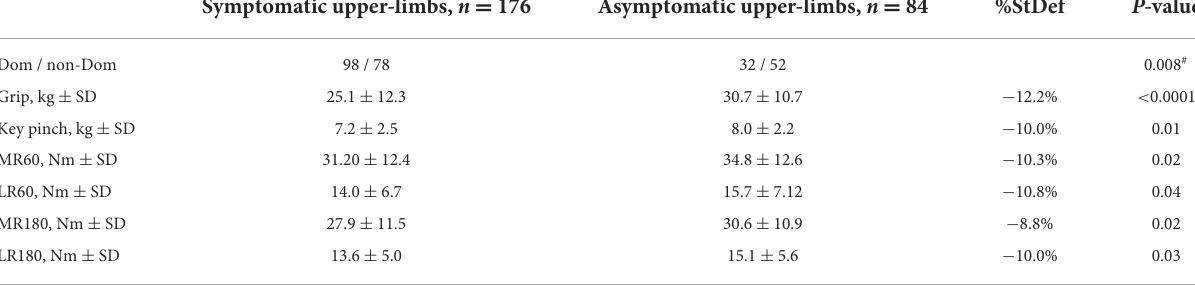
TABLE 1 Comparison of the strength between symptomatic and asymptomatic upper-limbs of patients with thoracic outlet syndrome (taking the upper-limb as unit). Symptomatic upper-limbs, n = 176 Asymptomatic upper-limbs, n = 84